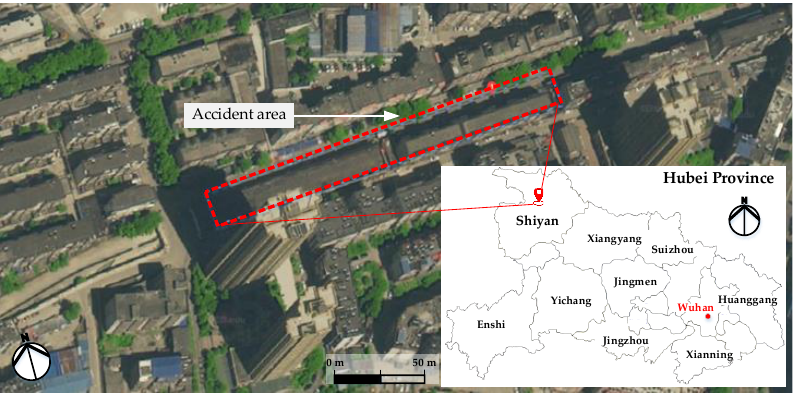
Figure 1. Location of the gas explosion site and overview of the surrounding